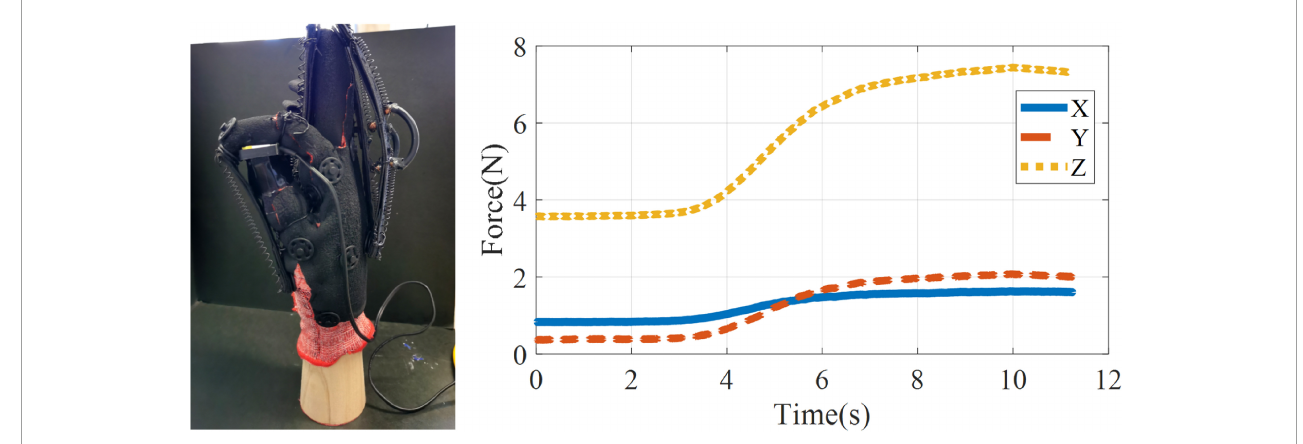
FIGURE13 Testing the fingertip force of the index finger and thumb of the exoskeleton glove on a wooden